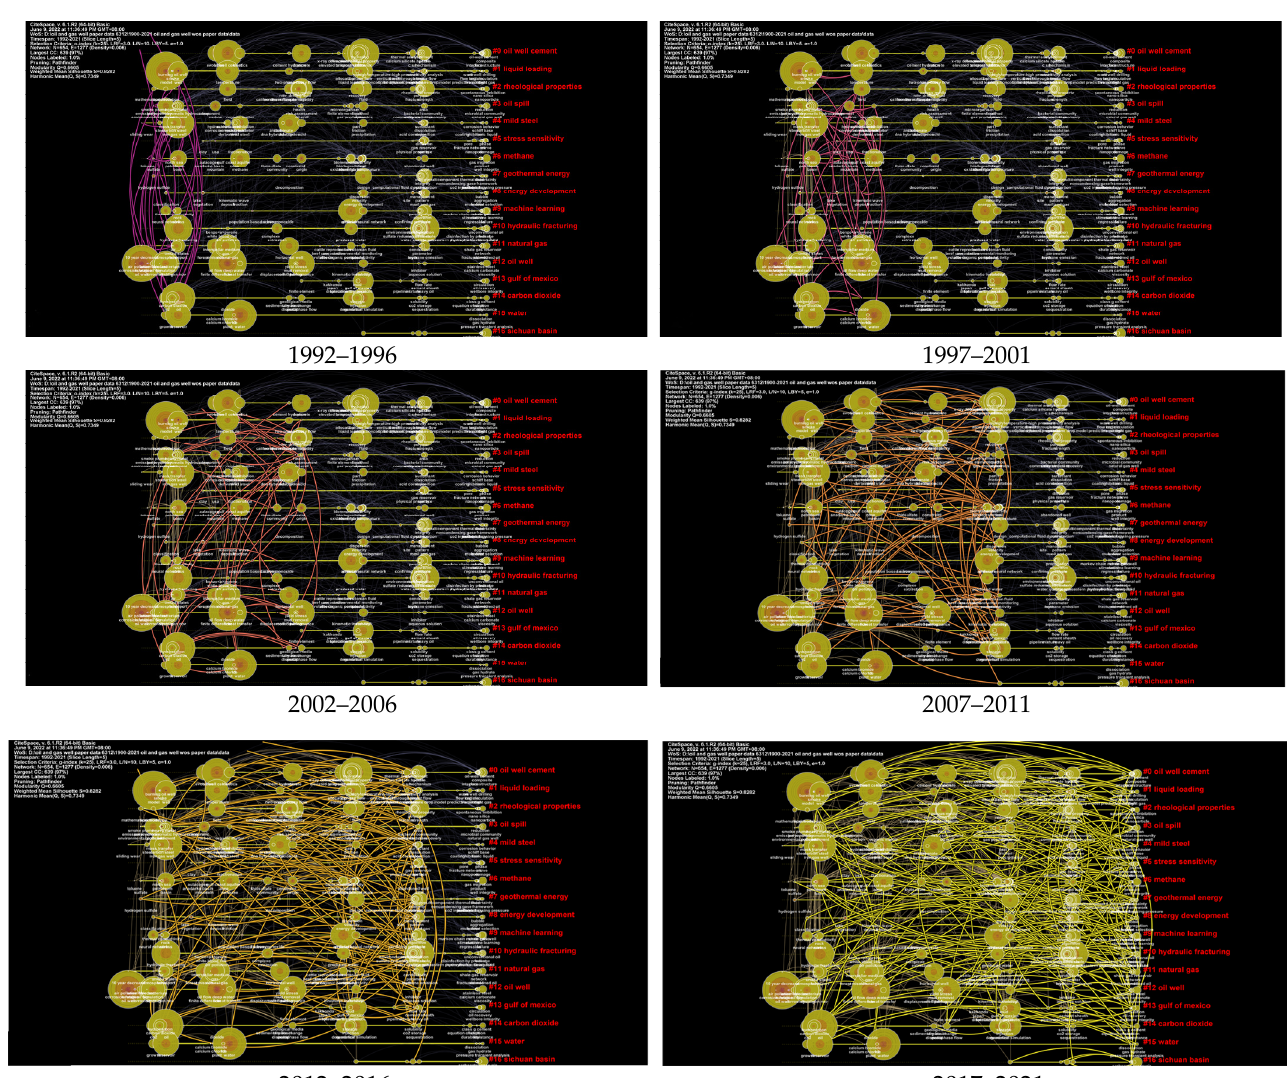
Figure 15. Mapping of the changes of frontiers in oil and gas wells research in different periods.